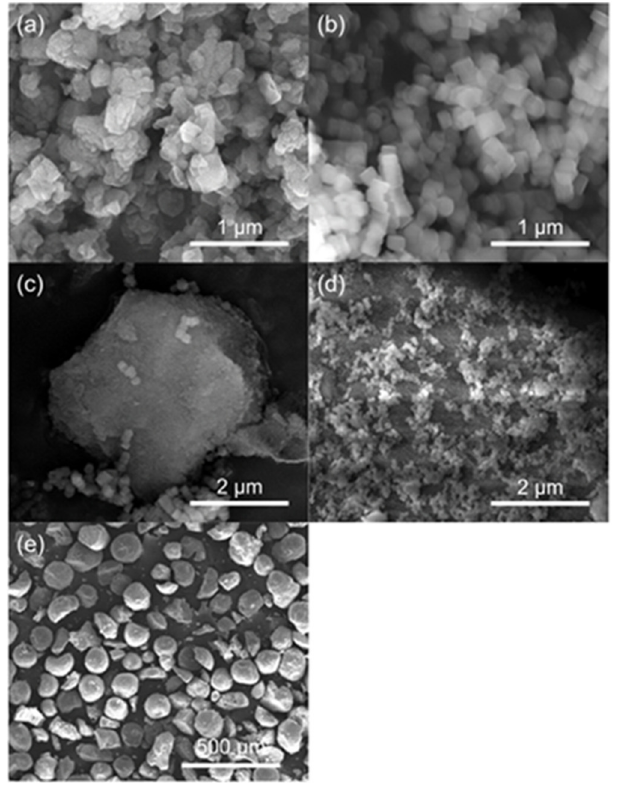
Figure 4. SEM images of c-HZSM-5 ( a ), n-HZSM-5 ( b ), PM-50/50 ( c ), Hybrid-50/50 ( d ), and γ -Al 2 O 3 ( e ).